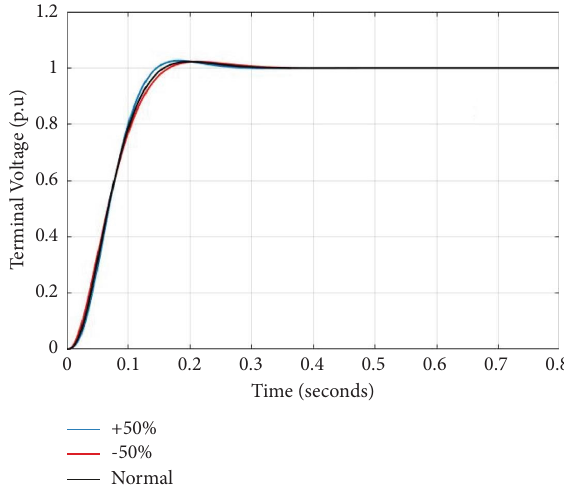
Figure 12: Response of terminal voltage using MESOBC for normal and ± 50% uncertainties in T